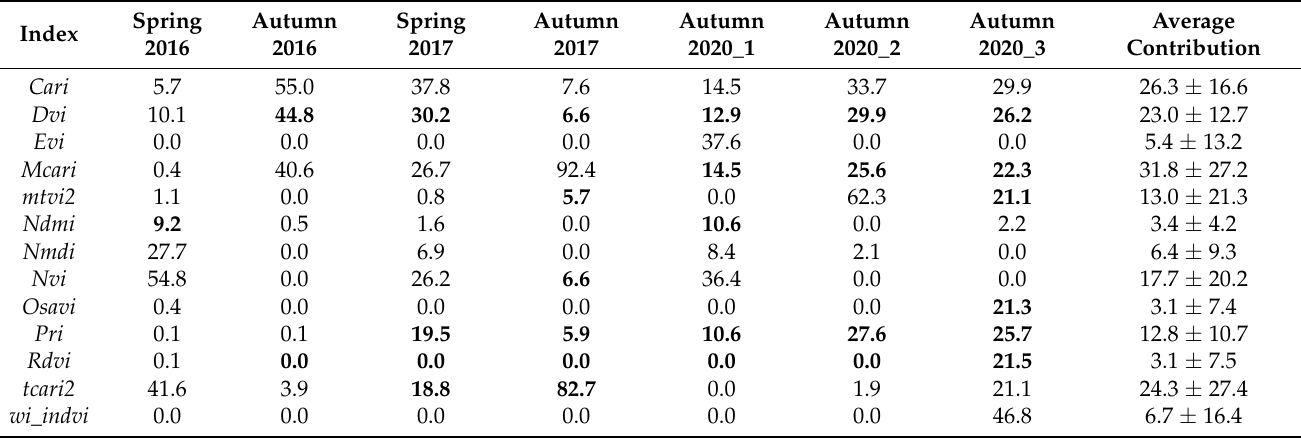
Table 4. Percentage of the contributions of hyperspectral indices for identifying waterlogged areas. Bold values represent the values of the variables not processed directly in the given case (period and location) and whose value was derived from a correlated variable according to Equation